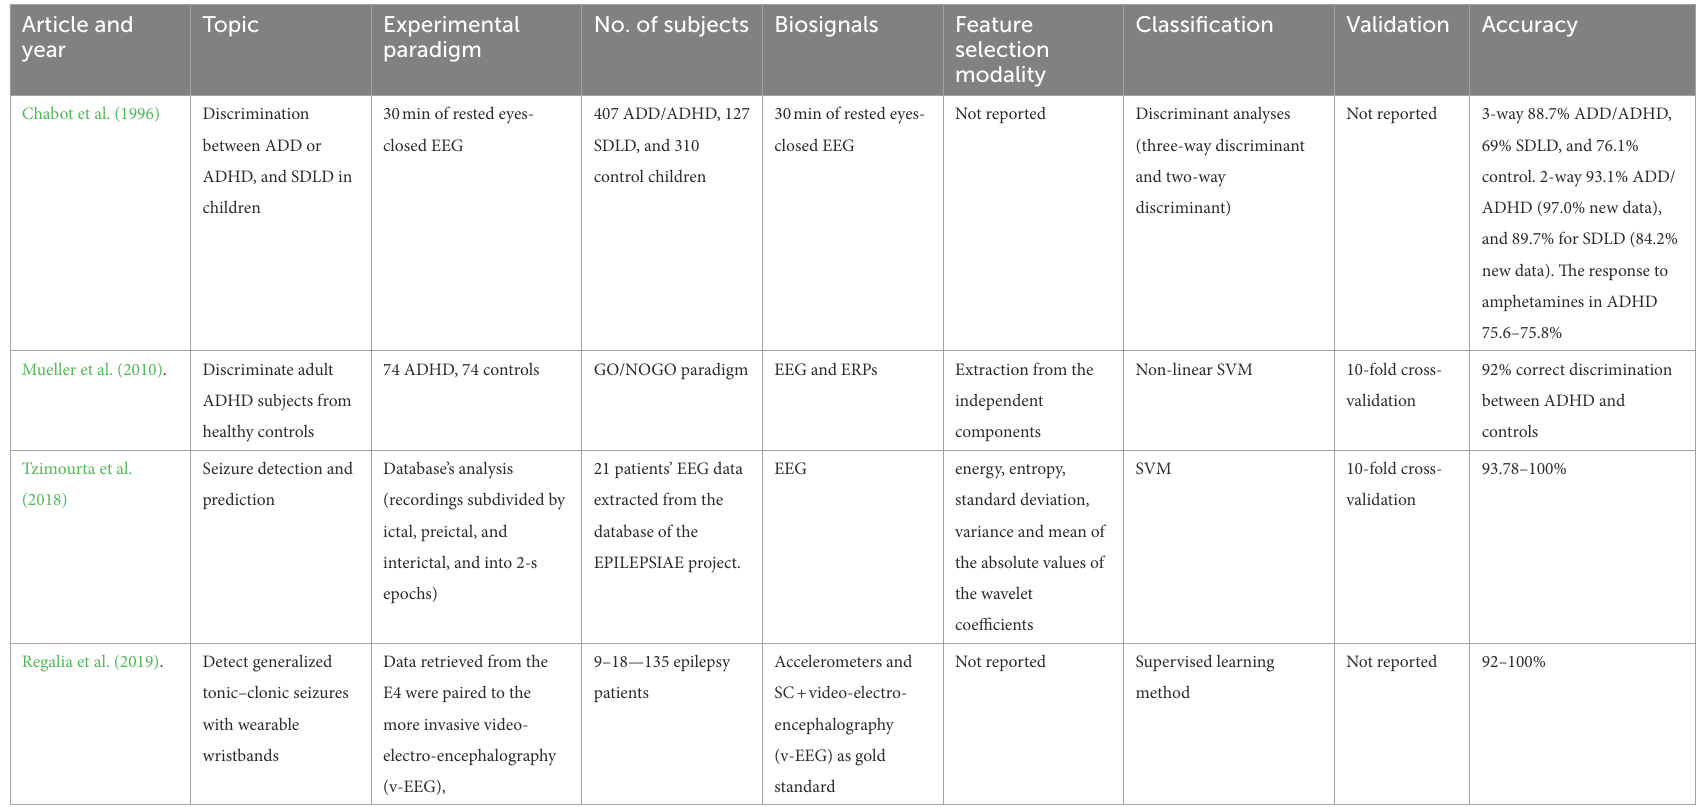
TABLE 2 The milestones research studies in Diagnostic Precision